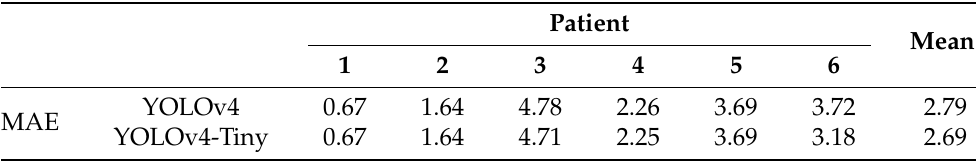
Table 7. Mean absolute errors for RR extraction in